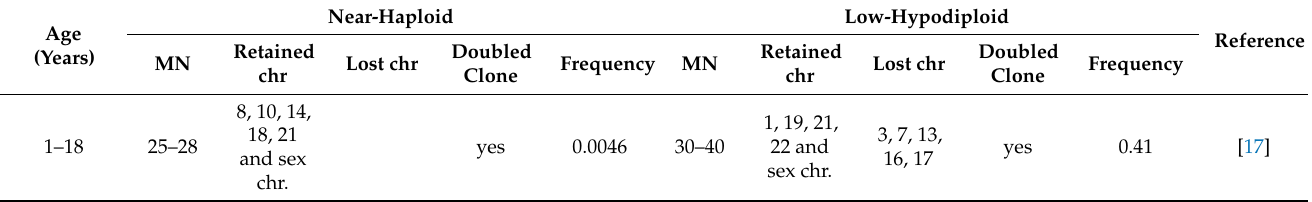
Table 3. Cytogenetic characteristics of B-ALL patients with <40